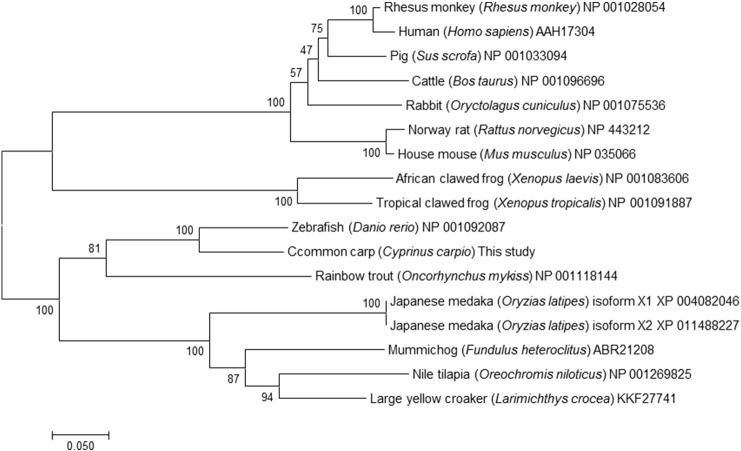
Evolutionary relationships of PXR. The neighbour-joining phylogenetic tree was constructed based on full length amino acid sequences. The scale bar represents 0.05 substitutions per site.